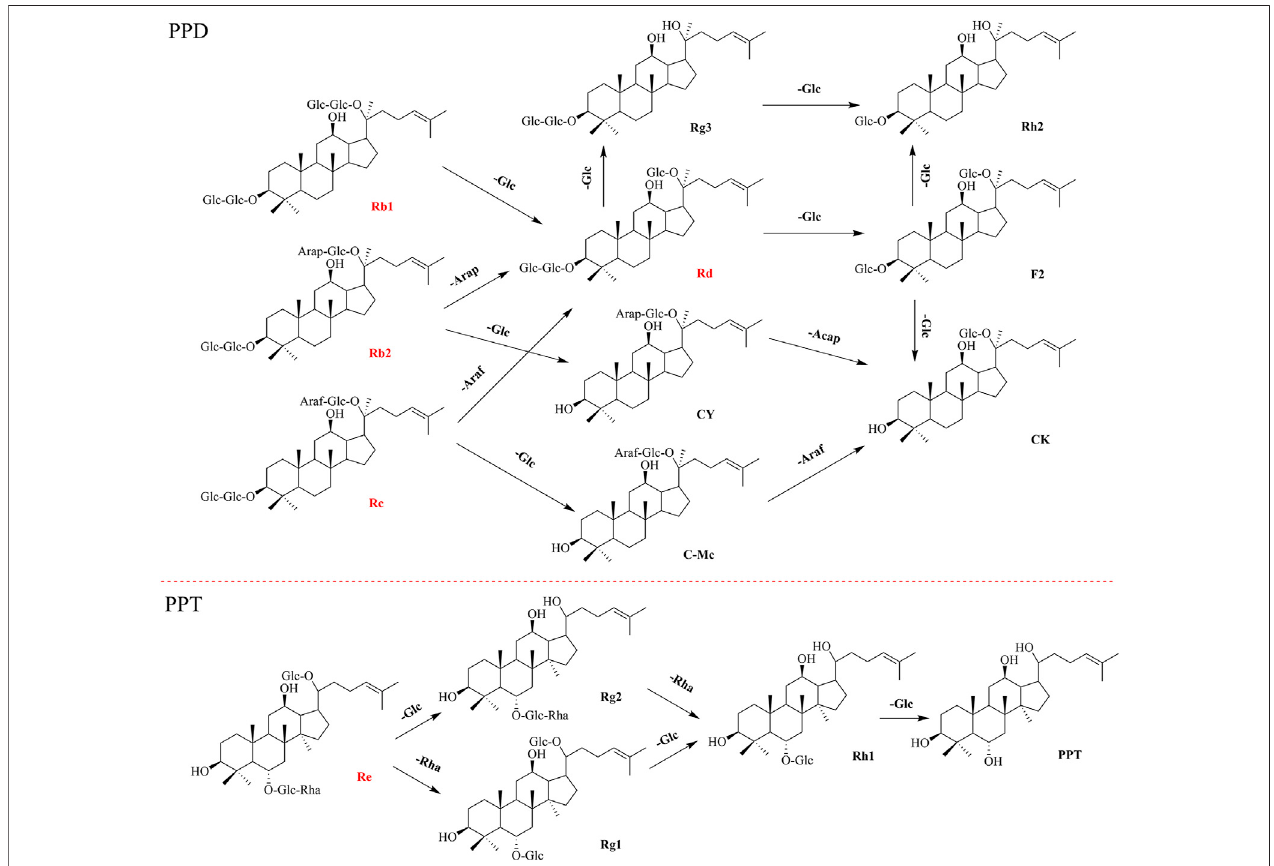
FIGURE4| Schematicdiagramofdirectedbiotransformationofmajorginsenosides(redsection)oftheextractsfrom P.ginseng roots.PPD(Protopanaxadiol-type ginsenoside) and PPT (Protopanaxatriol-type ginsenoside).